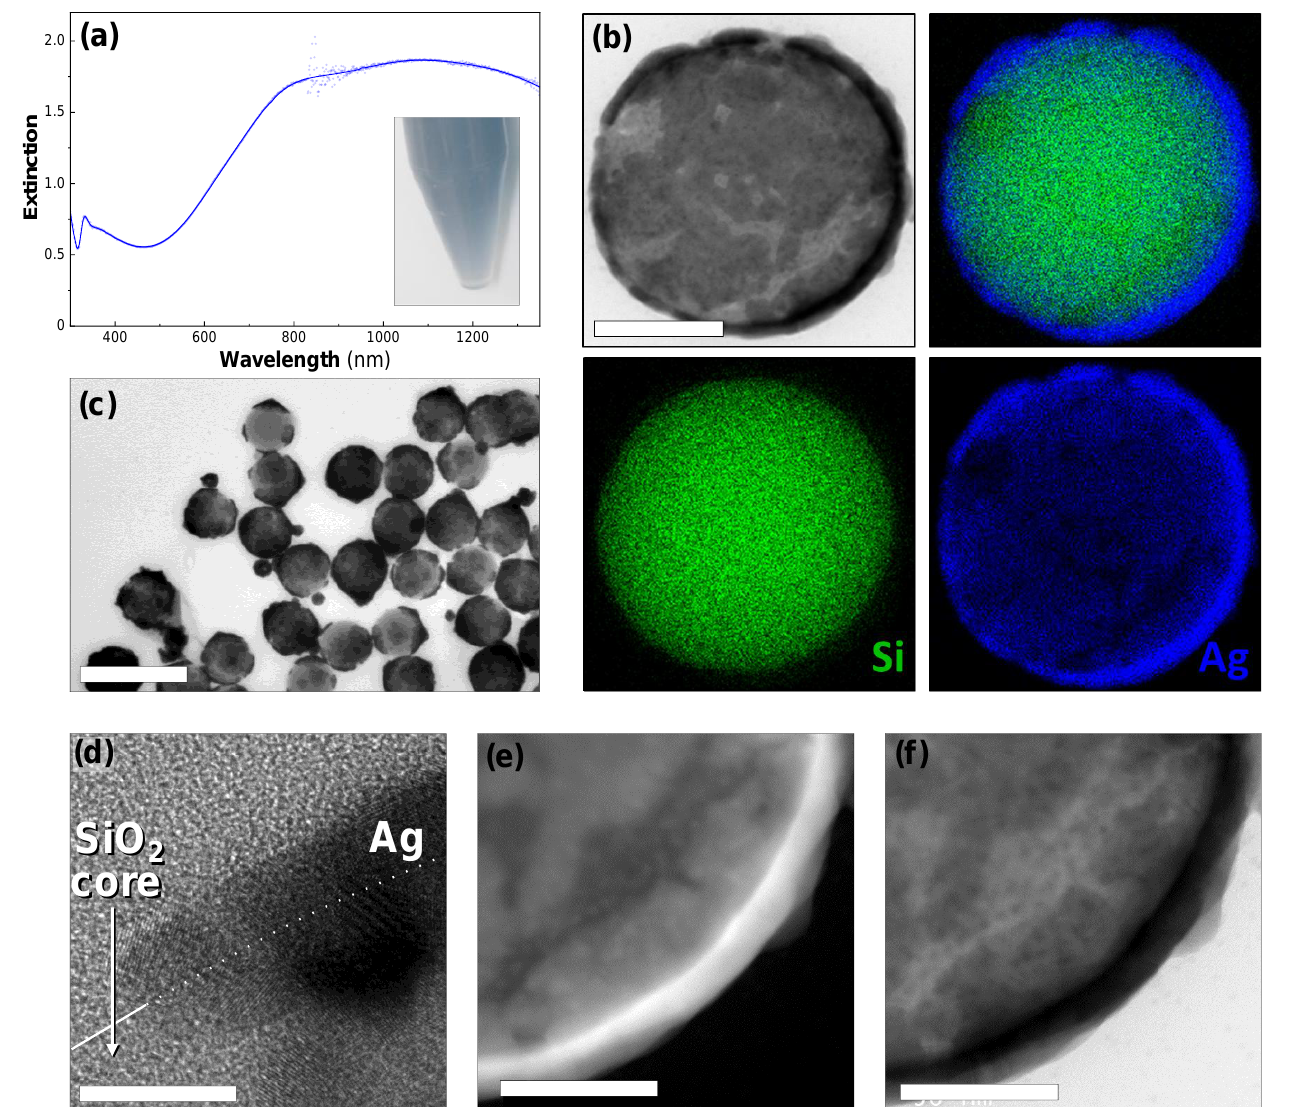
Figure 2. Ultrathin Ag nanoshell. ( a ) The UV – Vis – NIR spectrum of 200-nanometer silica particles covered with thin Ag shells. Inset: photograph of the sample dispersed in water. ( b ) The STEM – EDX elemental analysis showing silver (blue), silicon (green), an overlaid view (top right), and a corresponding bright-field STEM image (top left). The scale bar represents 100 nm. ( c ) A TEM image of ultrathin Ag nanoshells. The scale bar represents 500 nm. ( d ) A HR – TEM image of a particle surface. The white line on panel ( d ) indicates the silica-surface edge, with the particle on the lower half. The scale bar represents 2 nm. ( e ) Dark-field TEM image. The scale bar represents 50 nm. ( f ) Bright-field TEM image. The scale bar represents 50 nm. ( c – f ) are the same sample as ( a ).